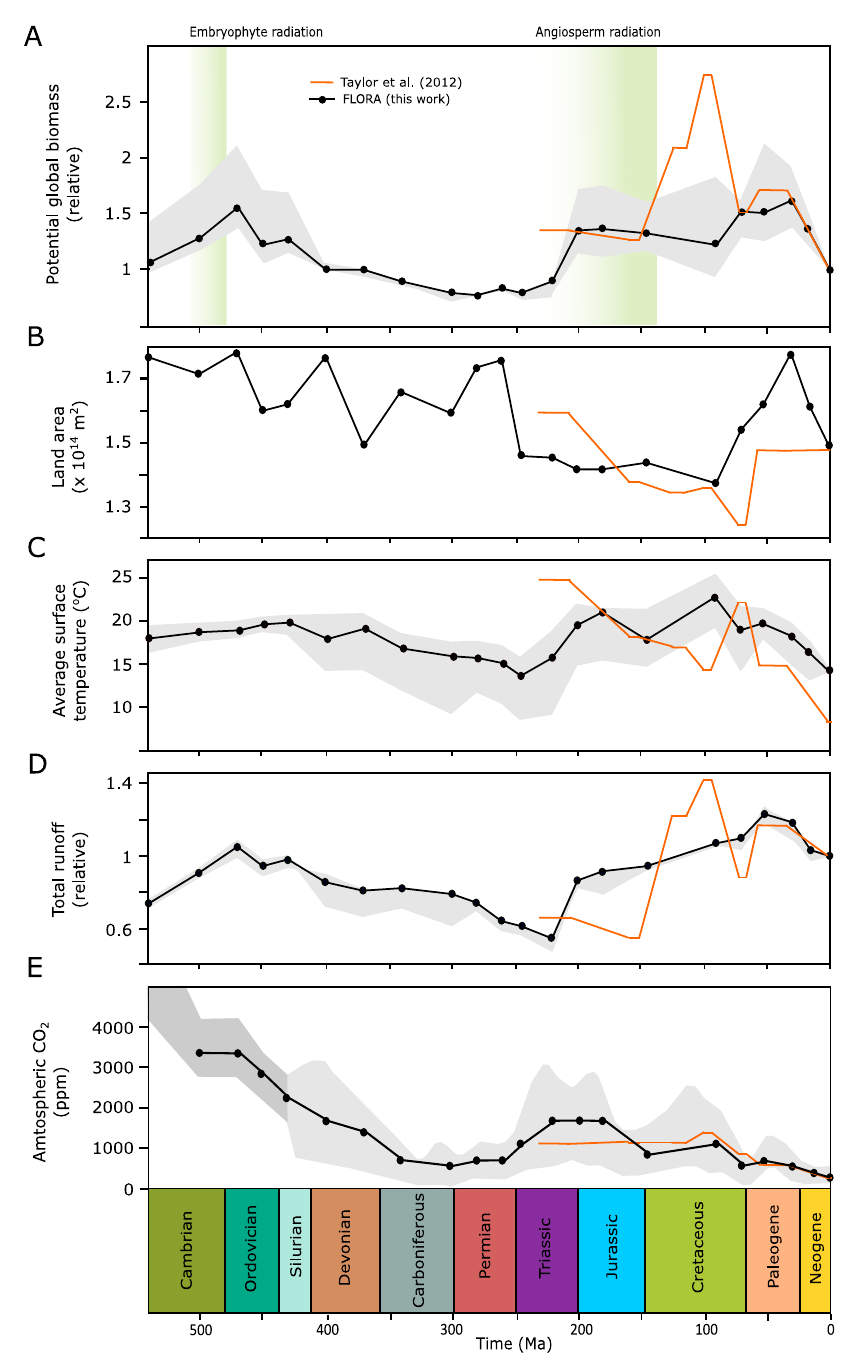
Fig.6|Globalpotentialrelativebiomass,runoff,averagetemperatureandCO 2 level during the Phanerozoic (540 – 0Ma). Temperature and runoff depend on thepredictedCO 2 level.Greyshadedarearepresentsthemin/maxvaluesobtained atthemin/maxCO 2 levelforeachpanelapartfromE.Timeperiodsarehighlighted at the bottom of the fi gure. Parameters and biomass used in Taylor et al. 16 are shown in orange; the length of the solid line represents time periods used. Ma: million years ago ( A ) Relative biomass over time (kg C relative to present). Green